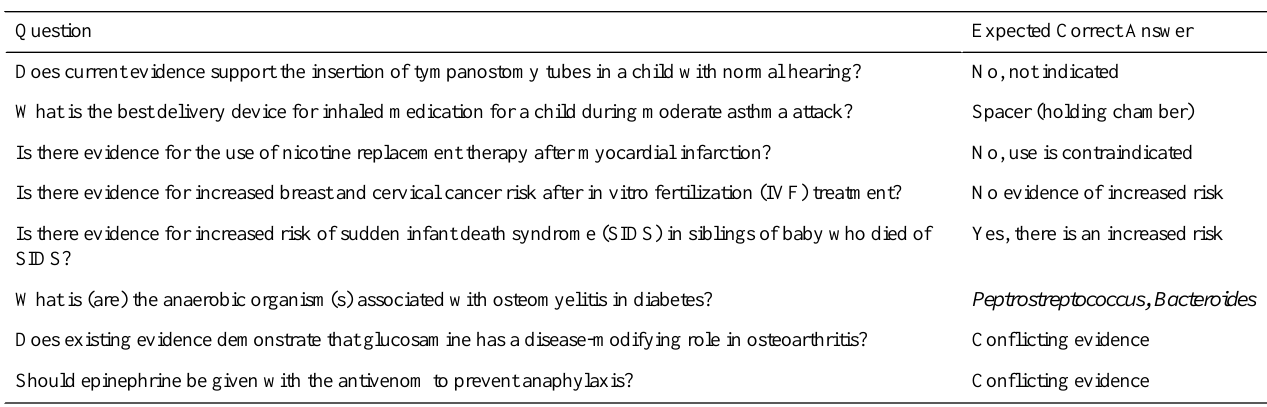
Table 1. Clinical questions presented to participants [9]